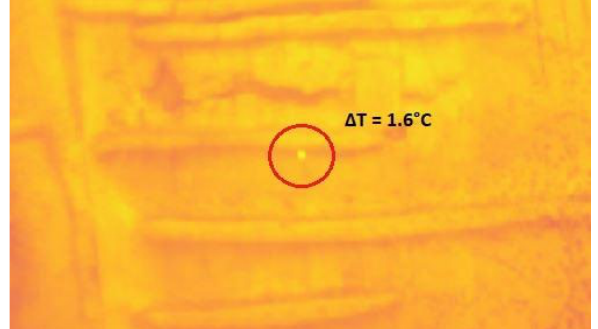
Figure 9. Detail of the thermal image with the modern coin placed on the